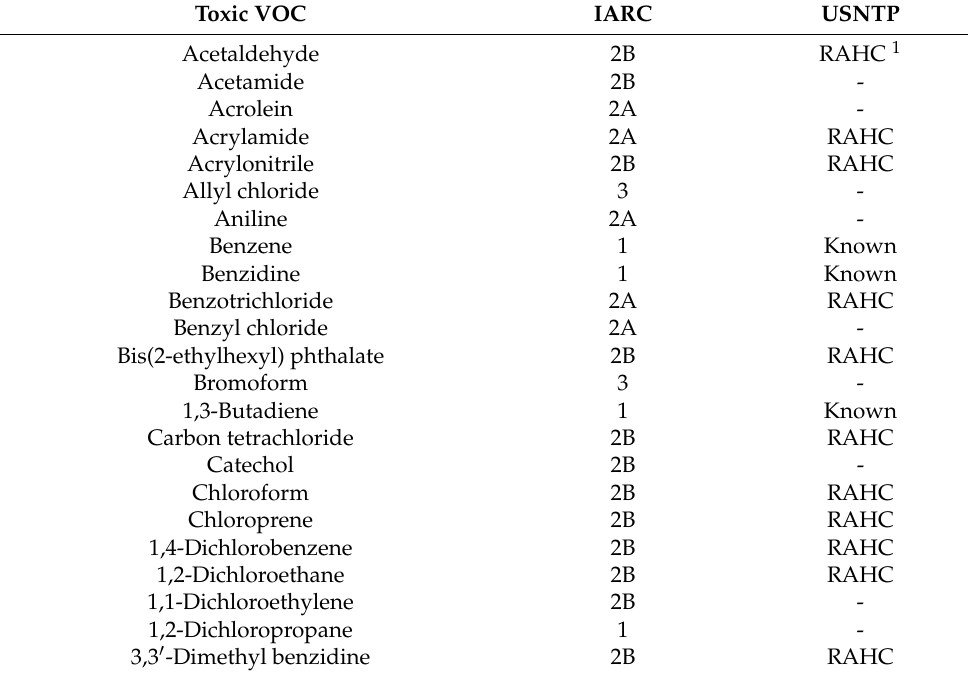
Table 2. Carcinogenicity classification (group) of toxic VOCs designated as HAPs in